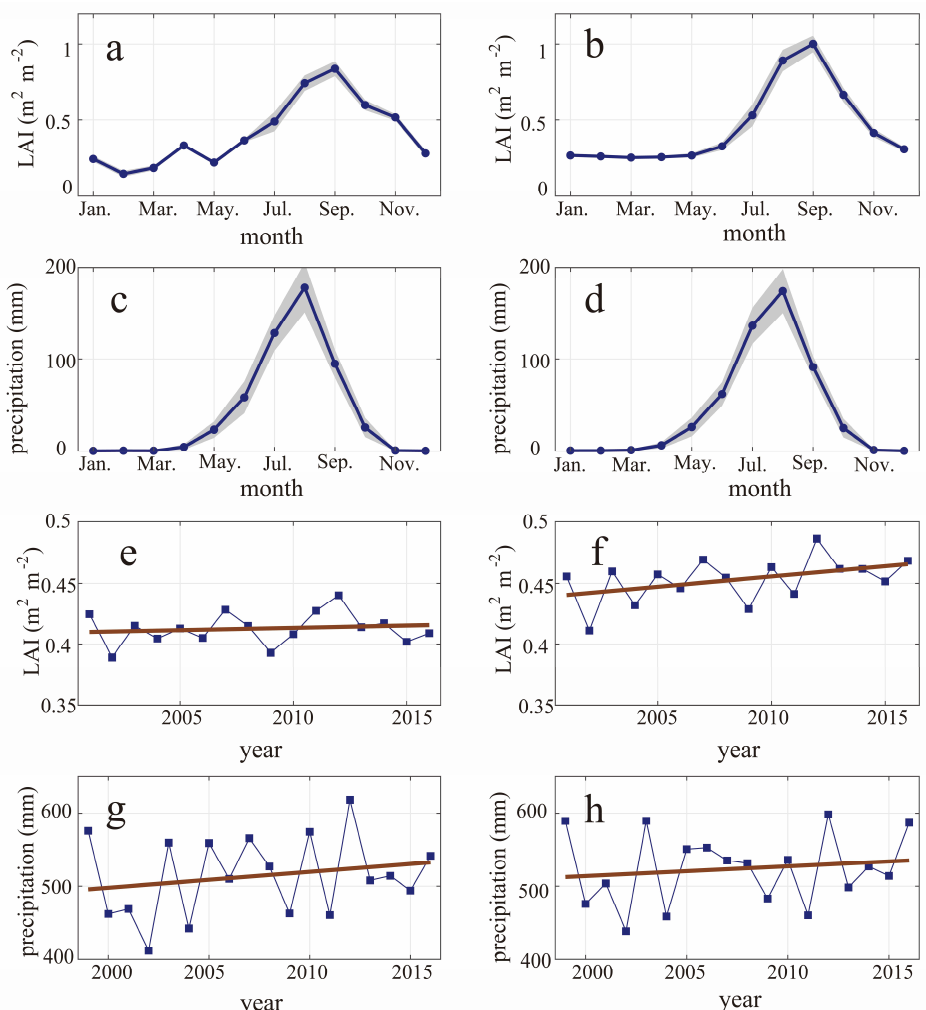
Figure 6. Time series of LAI and precipitation. ( a–d ) Blue curves are the averages of each month with standard deviations indicated by grey areas. ( e–h ) Interannual time series (blue curves with squares). ( a,e ) The GIMMS LAI3g from 2001 to 2016. ( b , f ) The MODIS LAI from 2001 to 2016. ( c , g ) The CRU precipitation from 1999 to 2016. ( d , h ) The TRMM 3B43 precipitation from 1999 to 2016.